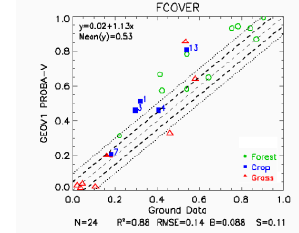
Figure 14: As in Figure 54 for FCover